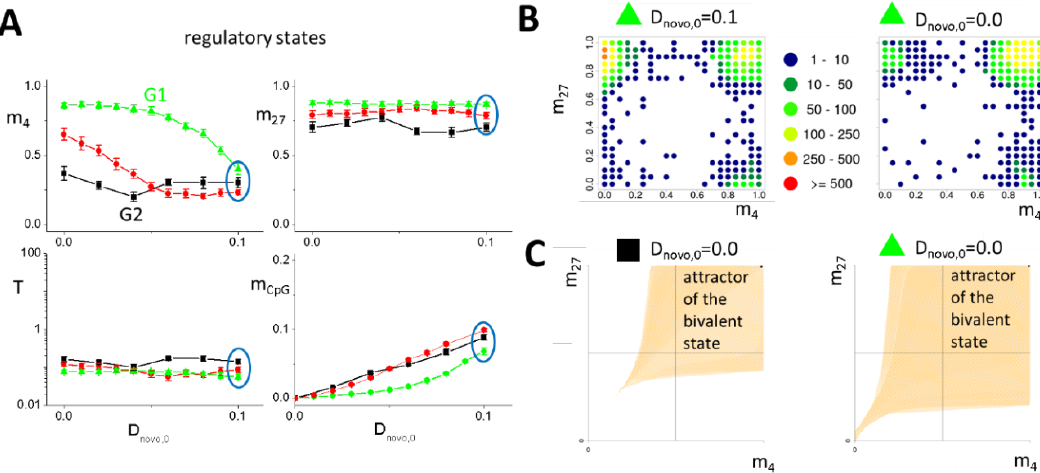
Figure 4. Regulatory states at decreased de novo DNA methylation activity. ( A ) Regulatory states depend on CpG binding of HMTs. At D novo,0 = 0.1, G1 (ε BS = 5.5, green) and G2 genes (ε BS = 5.0, black) occupy similar regulatory states. A decrease of D novo,0 at ε BS = 5.5 leads to an immediate recruitment of H3K4me3, while at ε BS = 5.2 (red), such an increase is observed below D novo,0 = 0.05 only. It nearly vanishes at ε BS = 5.0 (black). Error bars: SD owing to state fluctuations over time. ( B ) Histograms of occupation frequency of the (H3K4me3, H3K27me3) states for ε BS = 5.5. At D novo,0 = 0.1, a broad state distribution is seen (left), while at D novo,0 = 0.0, the population becomes homogeneous and G1 model genes are bivalent, that is, H3K4me3 and H3K27me3 modified, in most of the cells (right). ( C ) Changes of the occupation frequency with ε BS (5.0 (left), 5.5 (right), D novo,0 = 0.0) originate in a changed size of the attractor of the bivalent state (beige area).